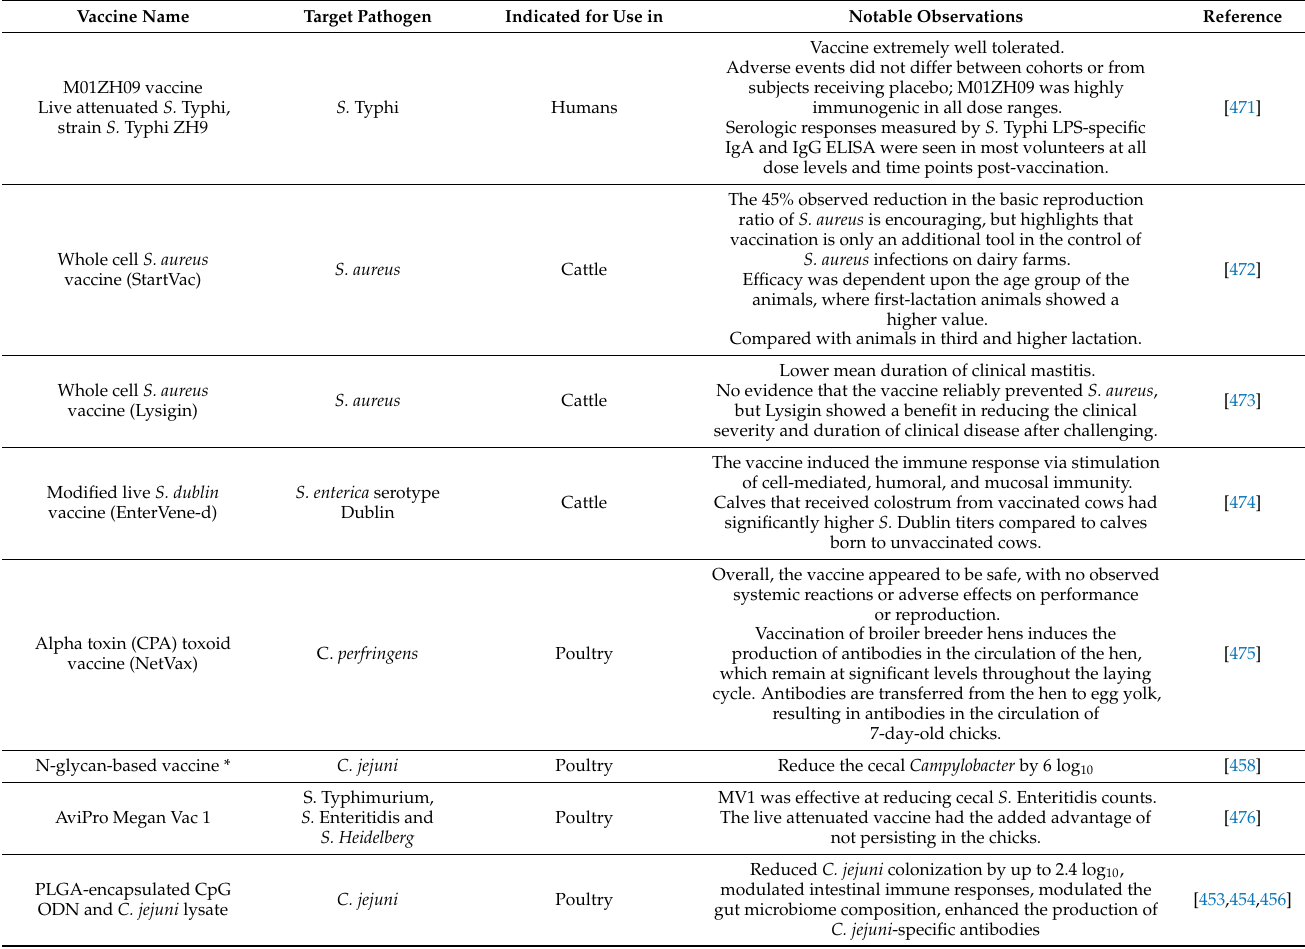
Table 7. Vaccines against infectious bacterial pathogens, either approved or in the research